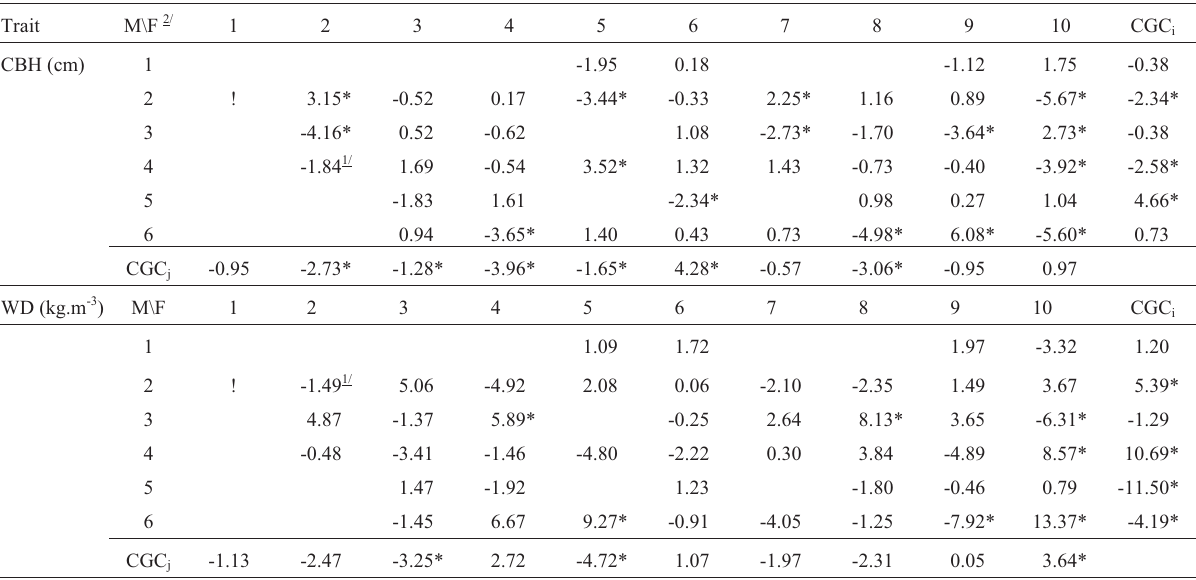
i ), general combining ability of group 2 (GCA j ) and specific combining